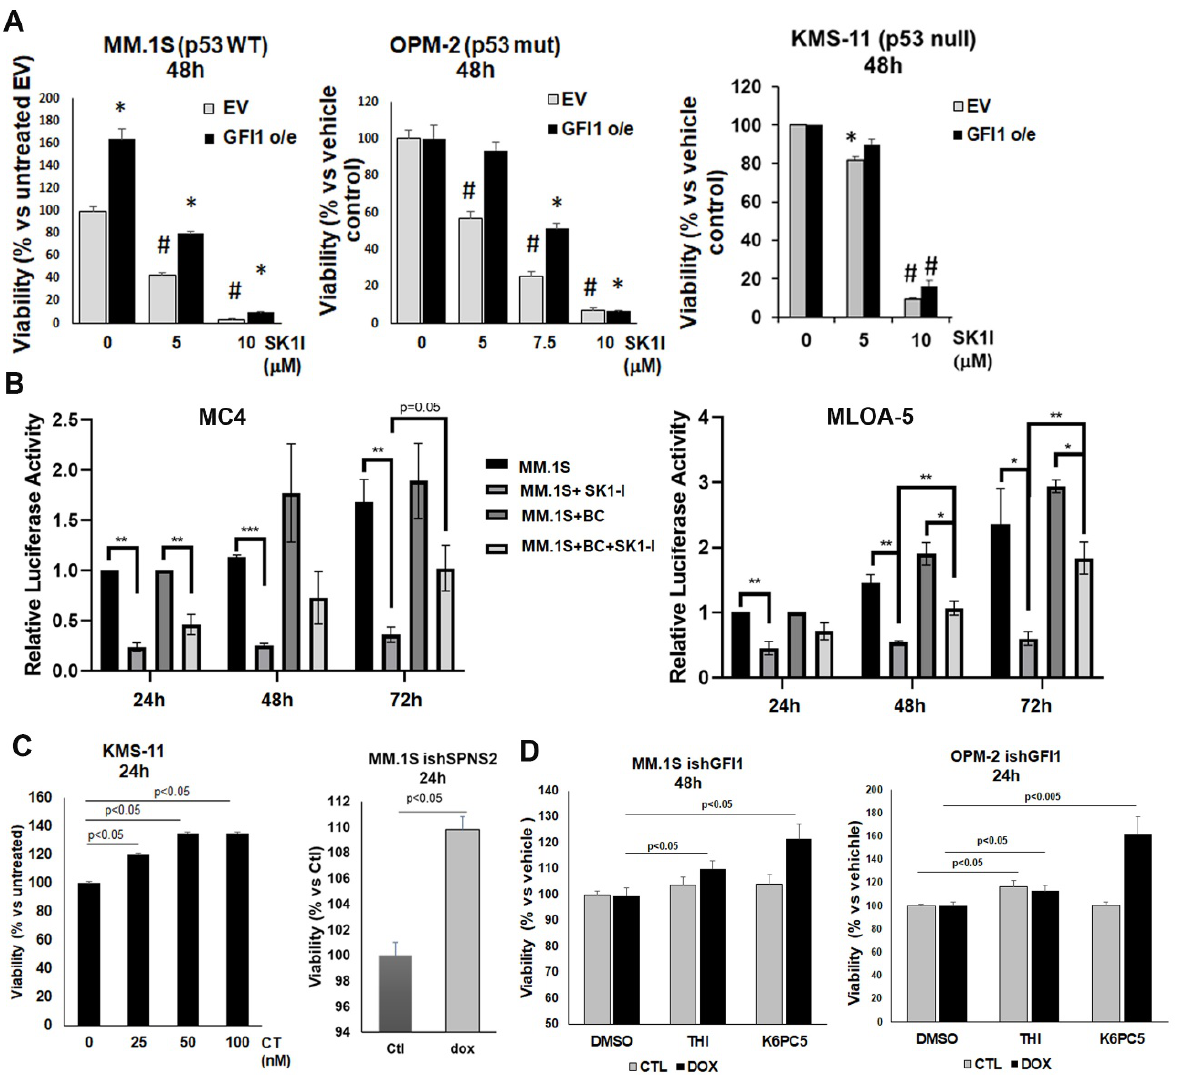
Figure 4. GFI1-dependent survival of MM cells is mediated by intracellular S1P levels. MM.1S, OPM-2, and KMS-11 GFI1 o/e and empty vector (EV) control cells were treated with different doses of SK1-I (5, 7.5 and 10 μM) or vehicle control (H 2 O) (0 μM) for 48 h. Viability was measured by AlamarBlue assay and reported as percent vs. untreated EV control (MM.1S left panel) or percent vs. vehicle control for each cell type to better appreciate the difference between EV and GFI1 o/e, (OPM-2 middle panel and KMS-11 right panel) (* p < 0.05 vs. untreated control and # p < 0.005 vs. untreated control) ( A ); Mouse pre-osteoblastic MC4 cell line (left panel) and mouse pre-osteocytes MLO-A5 cell line were co-cultured in a 3D-model with MM.1S-gLuc cells in a 1:5 ratio and treated or not with SK1-I (10 μM). Relative secreted Guassia luciferase activity in the supernatant was measured after 24, 48, and 72 h by a luminometer (* p < 0.05 , ** p < 0.01 and *** p < 0.0001) ( B ); SPNS2 specific S1P transporter was inhibited by either pharmacological treatment with Calcitonin (CT) (0, 25, 50, and 100 nM) of KMS-11 cells (left panel) or transcriptional repression (transduction with doxycycline-inducible shSPNS2 plasmid, 30% inhibition of SPNS2 gene expression in dox-treated vs. untreated controls after three days) in MM.1S cells. Viability was measured by AlamarBlue assay and reported as percent vs. untreated control ( C ); GFI1 knockdown was induced in MM.1S ishGFI1 and OPM-2 ishGFI1 cells by dox treatment (1 μg/mL) for three days. MM.1S ishGFI1 dox treated (40% GFI1 KD) and OPM-2 ishGFI1 dox treated (30% GFI1 KD) were then treated with THI (10 μM), K6PC5 (5 μM), or vehicle (DMSO) for an additional 48 h (MM.1S) or 24 h (OPM-2) and viability was measured by AlamarBlue assay and reported as percent vs. each cell type vehicle control ( D ).